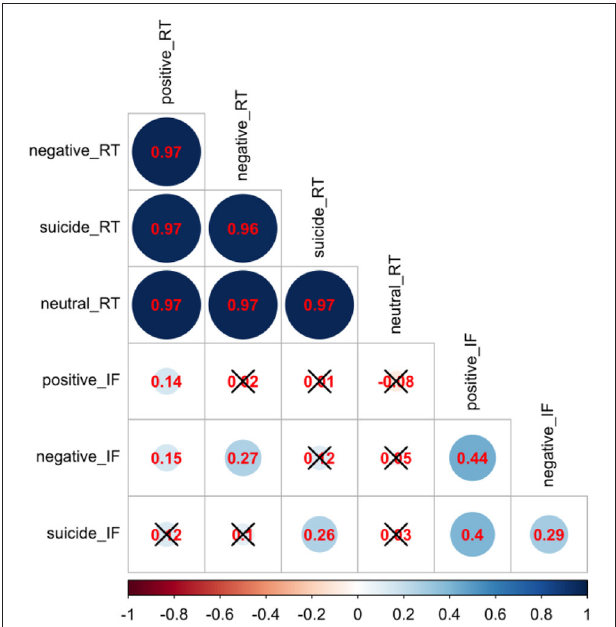
FIGURE 1 | Correlation analysis of Stroop task reaction time and interference scores. Red numbers are pairwise correlations, and a black cross represents an insignificant p -value.